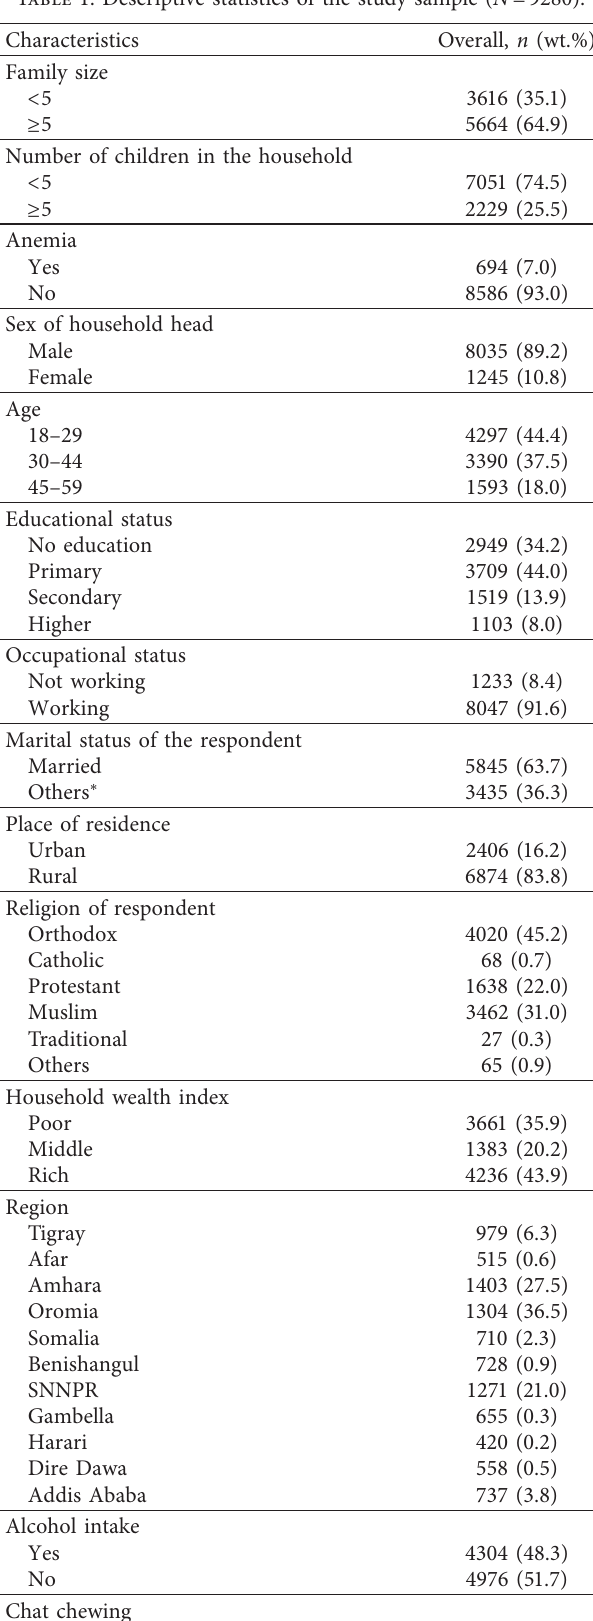
Table 1: Descriptive statistics of the study sample ( N � 9280).